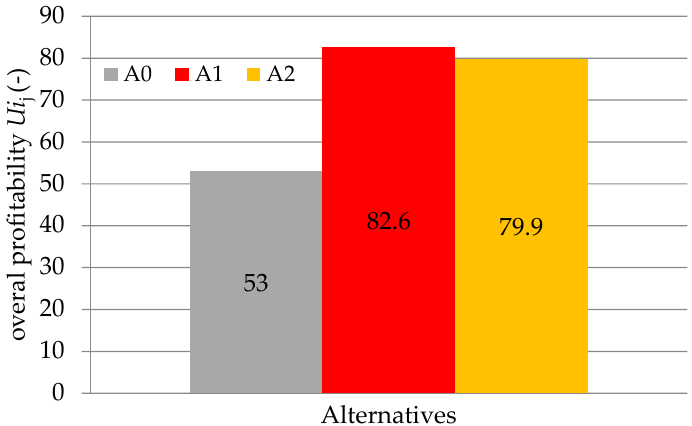
Figure 6. Summary comparison of the assessed alternatives.